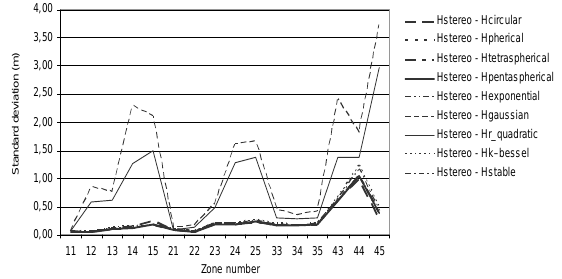
Fig 9. Standard deviations of DTM built by different semivariogram